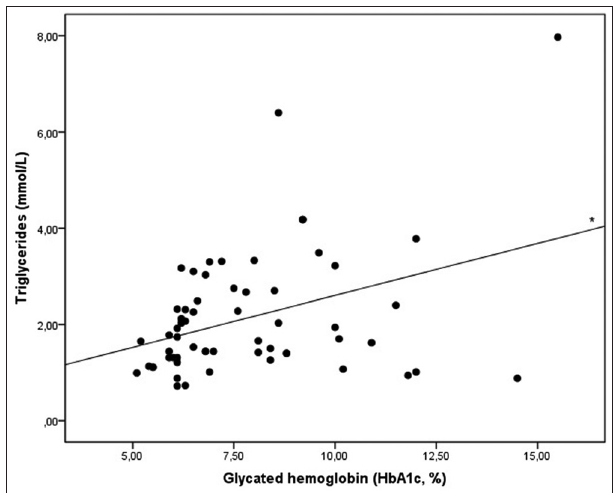
FIGURE 3. Correlation between triglyceride/HDL cholesterol ratio and concentration of glycated hemoglobin (* r =0.335, p